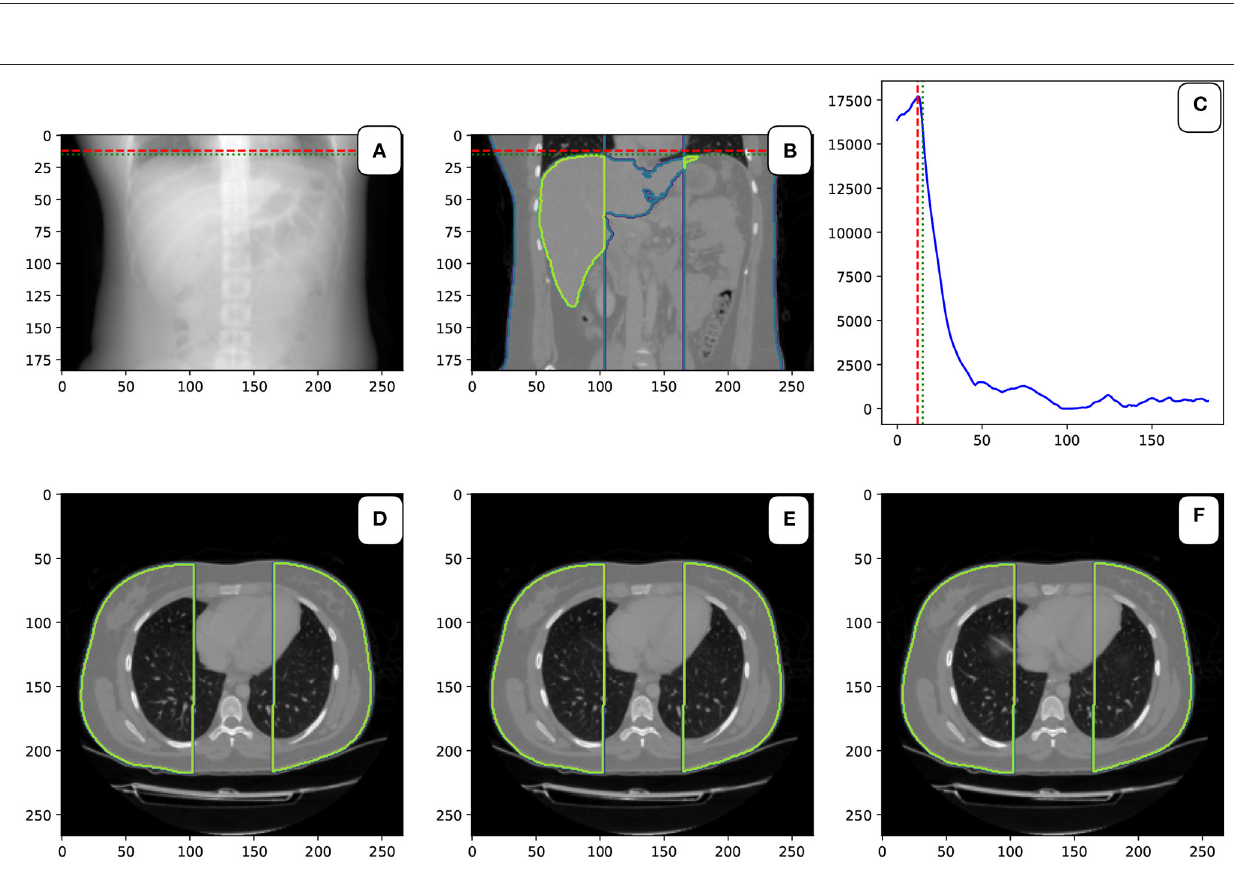
FIGURE 4 | Localization of the top of the diaphragm: Image (A,B) in the first row show the CT scan’s coronal view. The green and blue delineation show the liver and the mask. The red dashed line is the detected level of the top of the diaphragm. The green dashed line shows the top level of the liver. The image (C) in the first row is the plot with the area of the masked cavity in square mm. Images (D–F) show three consecutive axial slides of the CT scan. In the middle (E) is the slice from the top level of the diaphragm can. On the left (D) is the slice above the diaphragm. The right image (F) shows the slide under the top level of the diaphragm. A small “shadow” of the diaphragm can be seen in this